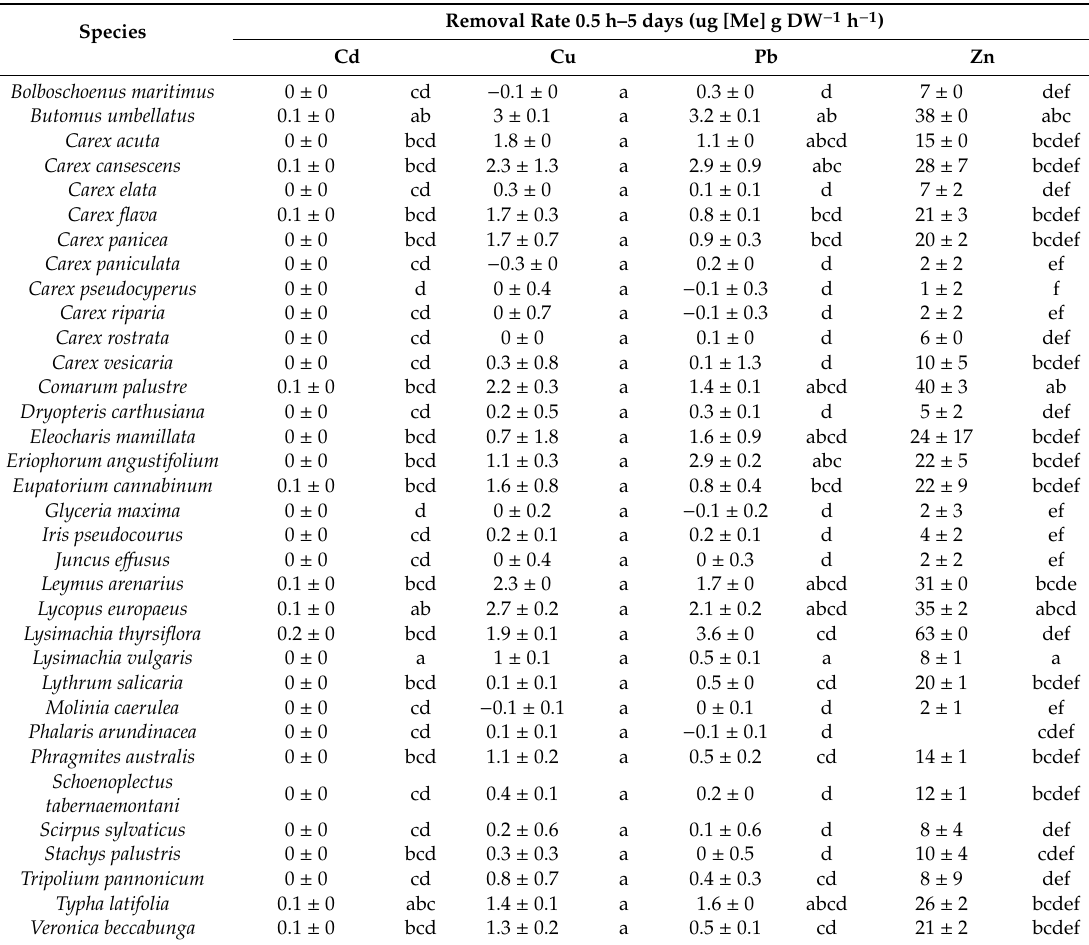
Table 3. Removal rates during the period 0.5 h–5 days. Di ff erent letters within each metal denotes di ff erences among species, where p < 0.05. n = 3, ±